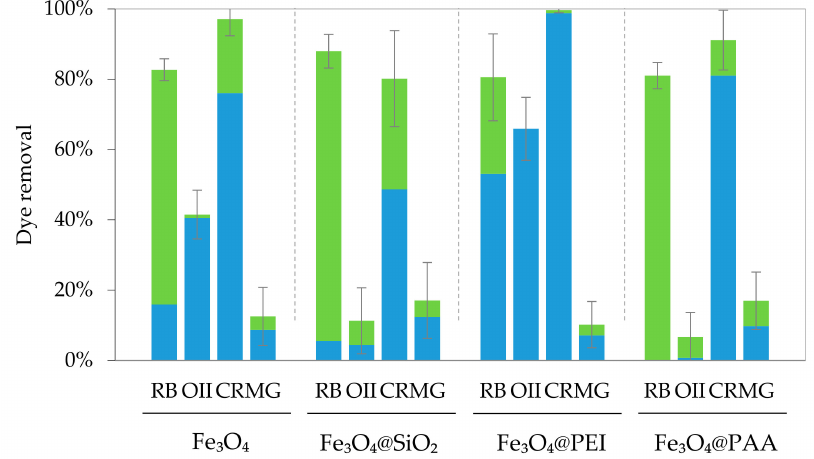
Figure 3. Percentage of dye adsorption (blue) and degradation (green) for C 0 = 10 mg L − 1 after 3 h